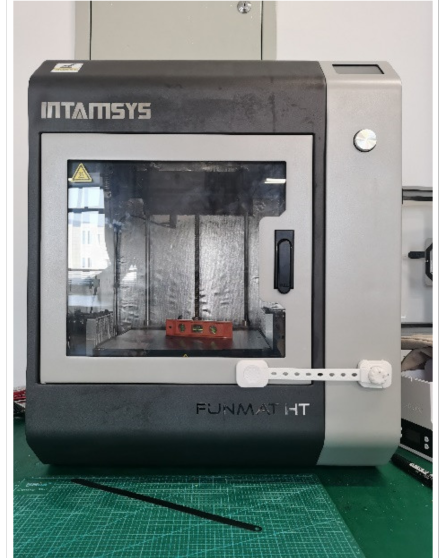
Figure 1. FUNMAT HT printer.